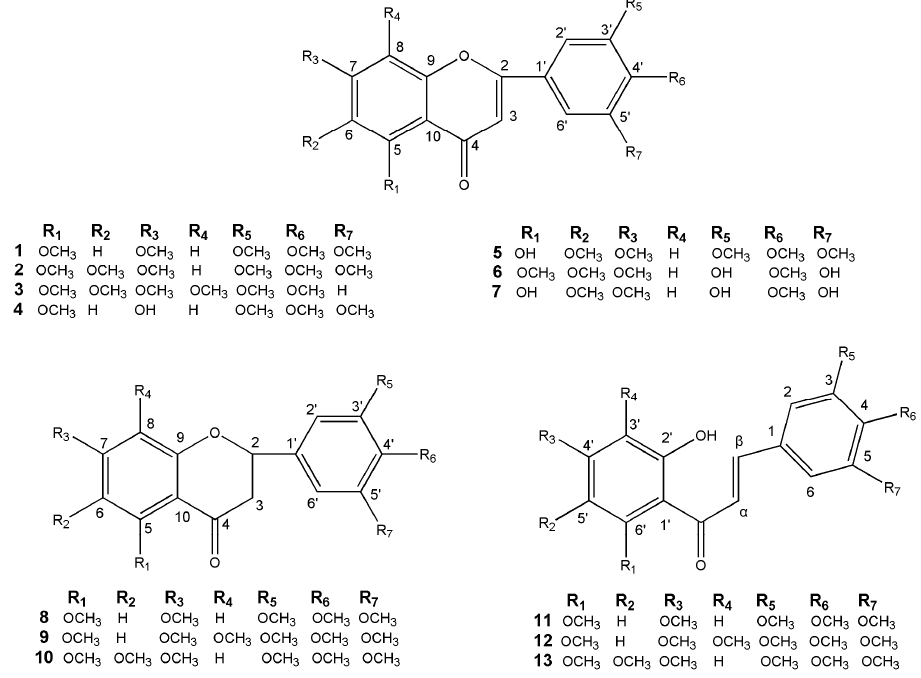
Figure 1. Chemical structures of flavonoids 1 – 13